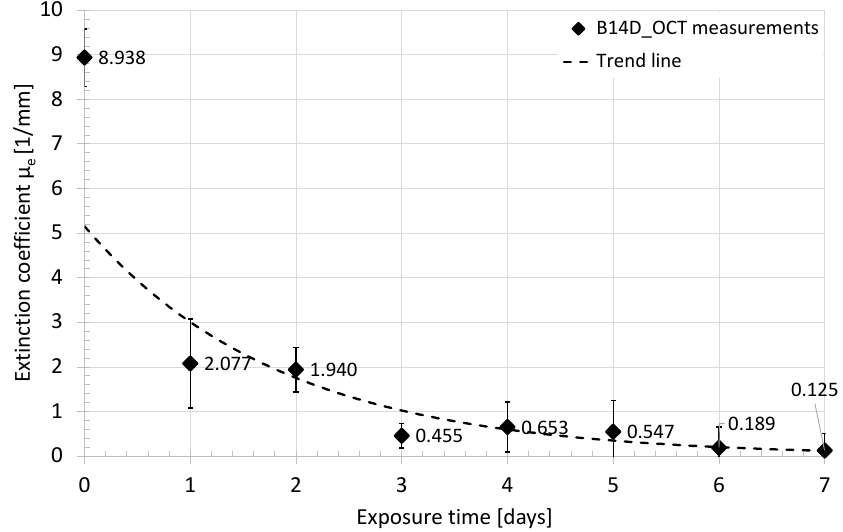
Figure 7. The average value of the extinction coefficient measured in the 14-day period—sample B14D_OCT.